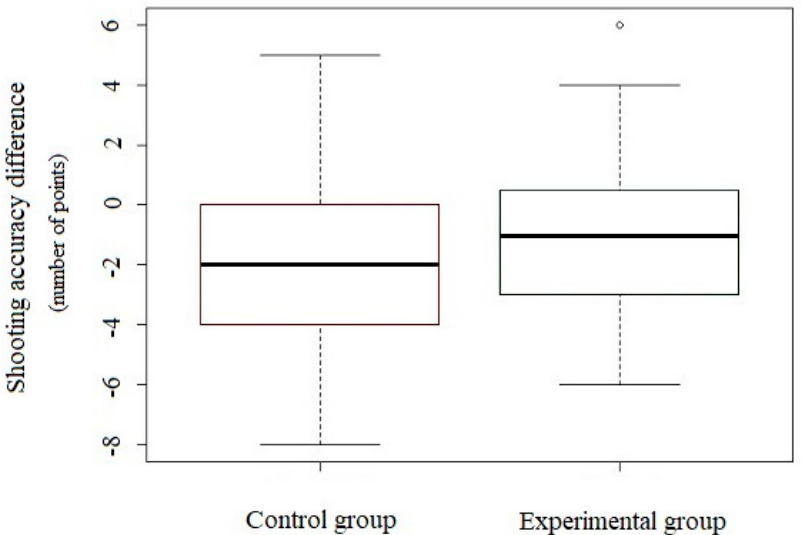
Figure 5. Changes in shooting accuracy before and after the intervention (control group n = 15, experimental group n = 15); horizontal line in the box = median; vertical line = data variability outside the upper and lower quartiles. Intermittent points indicate outliers.